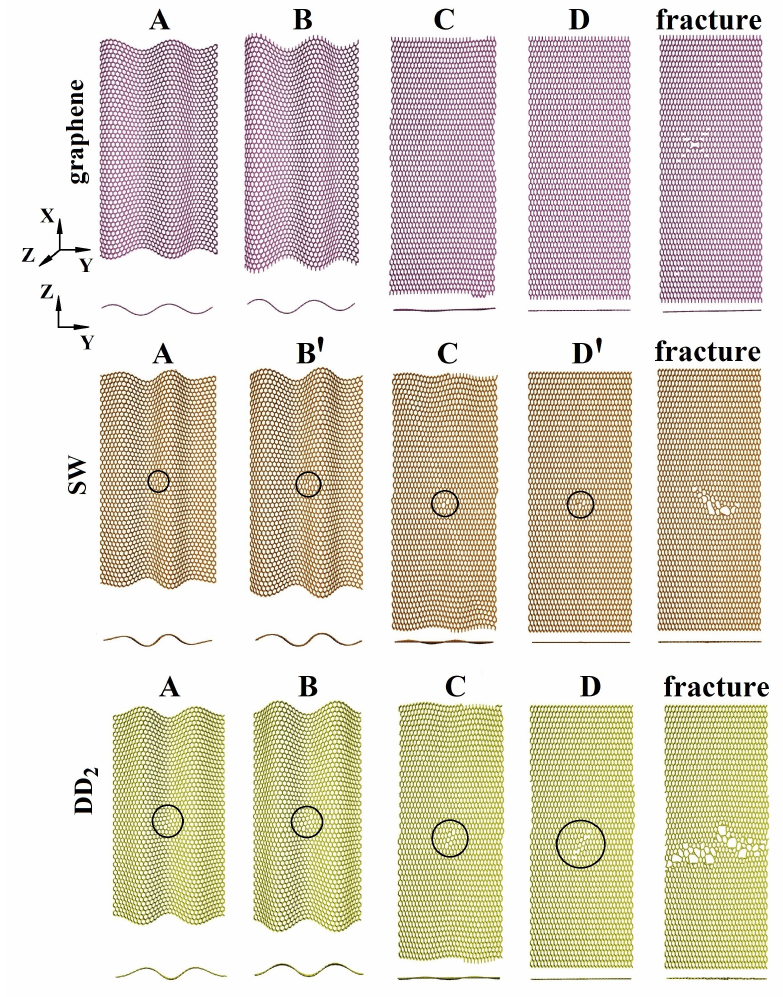
Figure 6. Snapshots of graphene, graphene with SW defect and with DD 2 under tension along armchair direction at T = 0 K. Snapshots are presented in a perspective view and in a projection on yz plane. The defect is shown by a black circle. Corresponding dots A–D, B’, D’ are from Figure